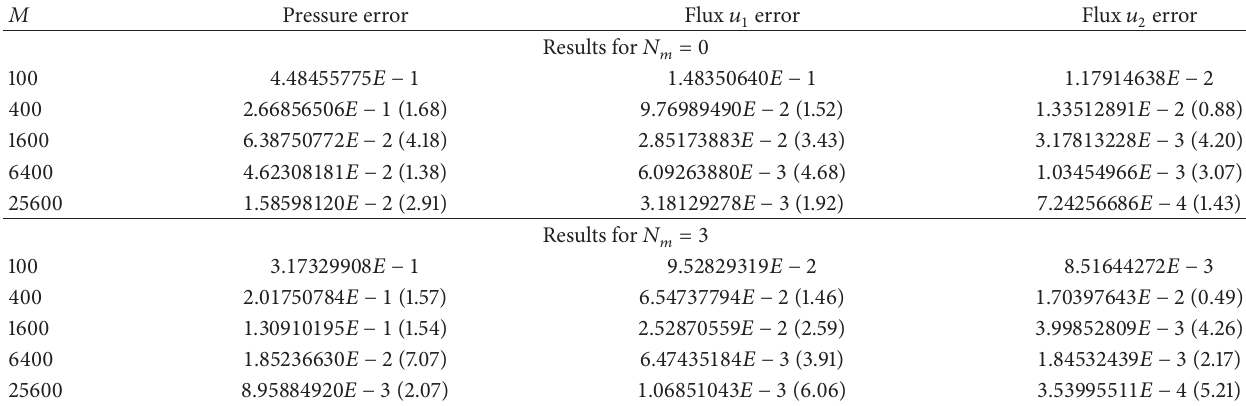
Table 2: Stochastic convergence for KL-MC method, 𝑀 max = 102,400. Convergence ratios are given in parentheses.